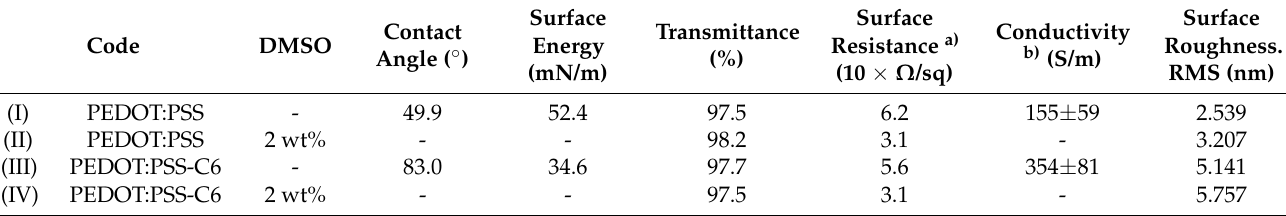
Table 2. Properties of PEDOT:PSS and PEDOT:PSS-C6 films and their doped films.